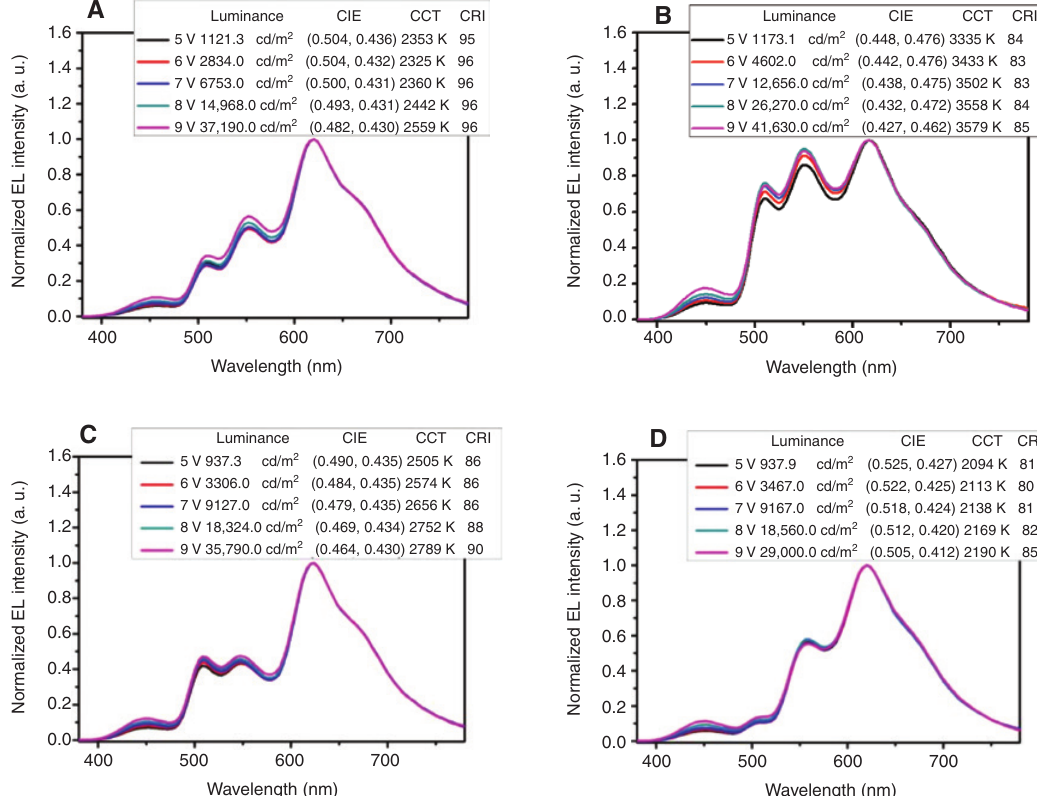
Figure 4: EL spectra, CIE coordinates, CCT, and CRI of all four white devices at different driving voltages. Note: the luminances for four white devices are listed at different driving voltages, (A) for device W1, (B) for device W2, (C) for device W3, (D) for device